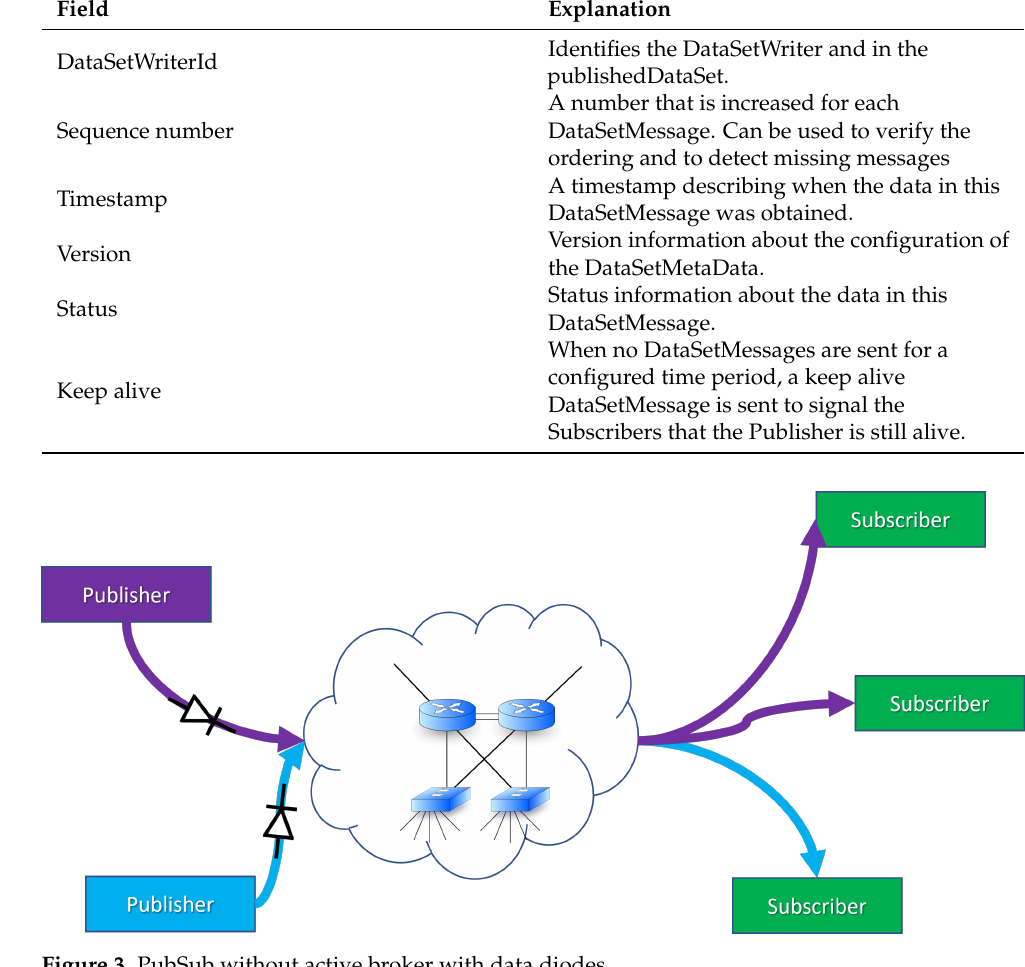
Figure 3. PubSub without active broker with data